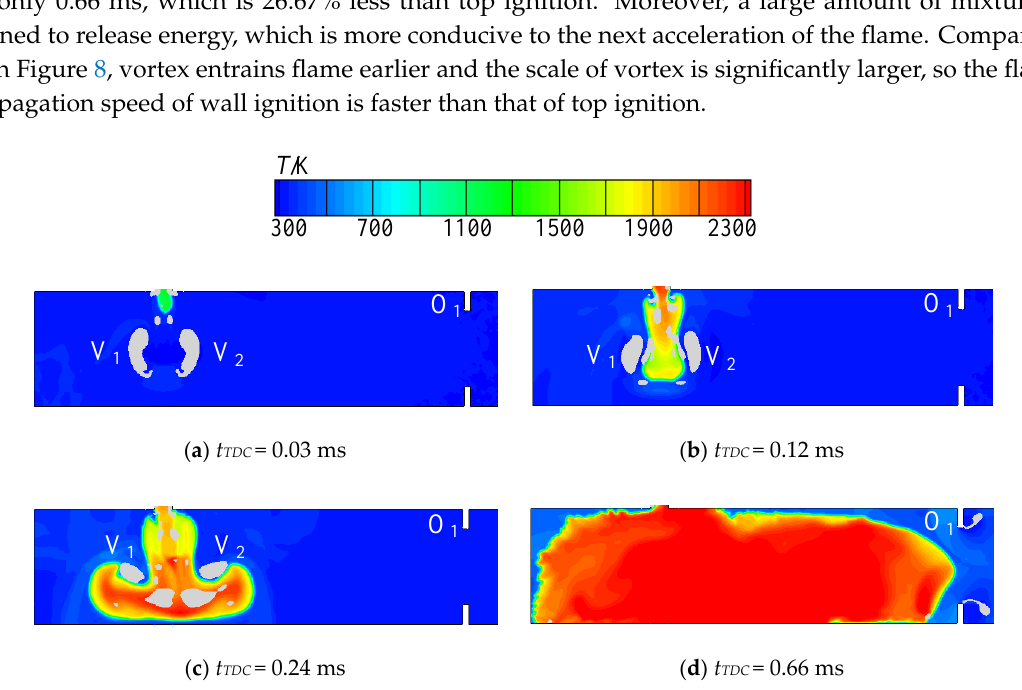
Figure 15. Variations of temperature and Q criterion field of wall